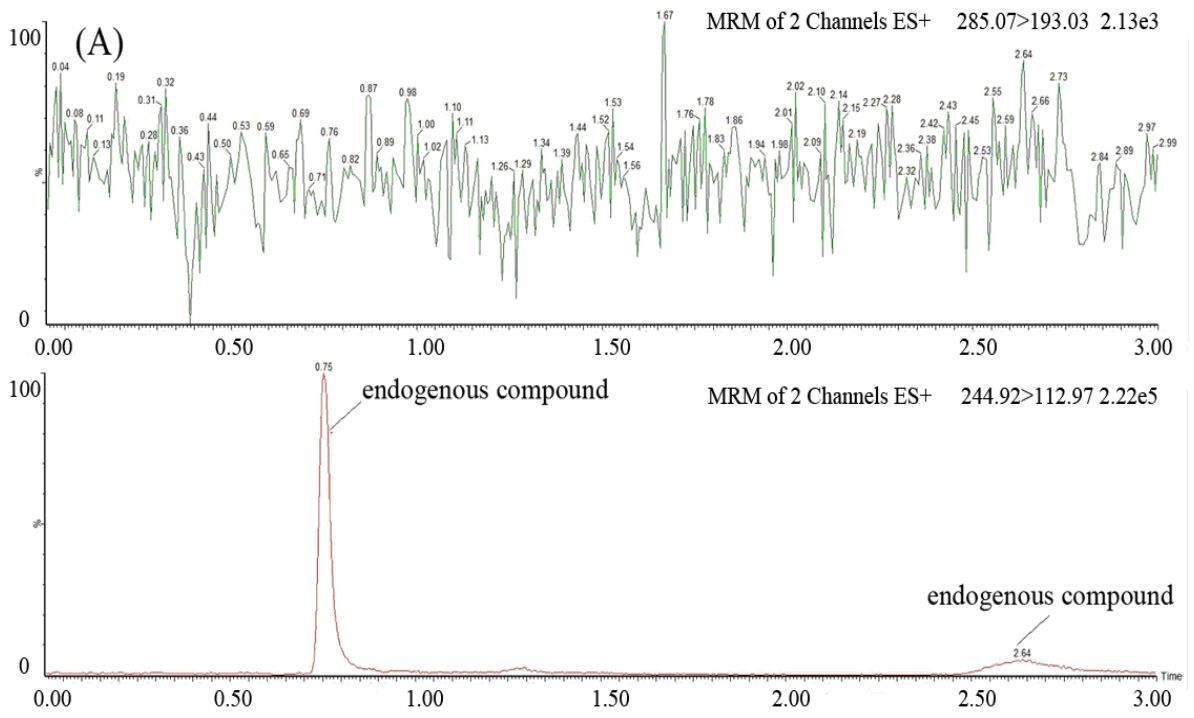
Figure 2. Representative MRM chromatograms of diazepam (IS, I) and azacitidine (II) in rat plasma: ( A ) a blank rat plasma sample; ( B ) a blank rat plasma sample spiked with azacitidine (20 ng/mL) and diazepam (2,000 ng/mL); ( C ) a rat plasma sample following intravenous administration of azacitidine at 2.5 mg/kg to Sprague-Dawley